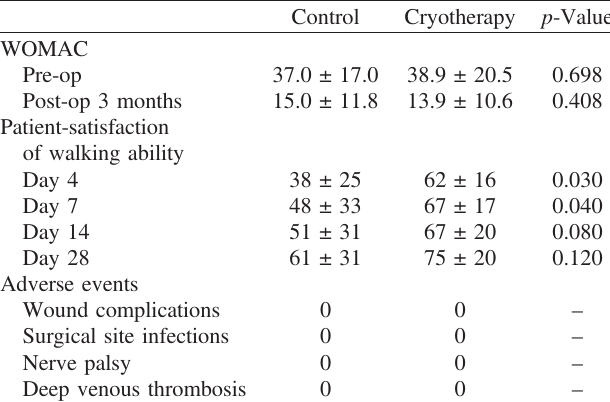
Data are shown as mean ± standard deviation or